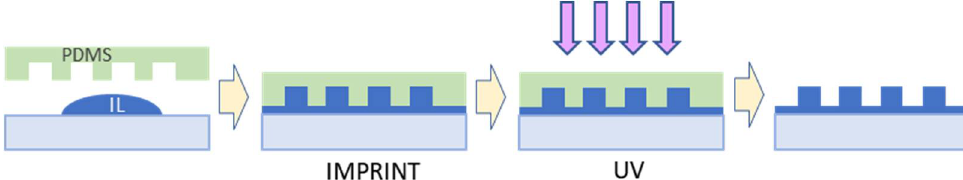
Figure 7. The scheme of the imprint process with PDMS mold.